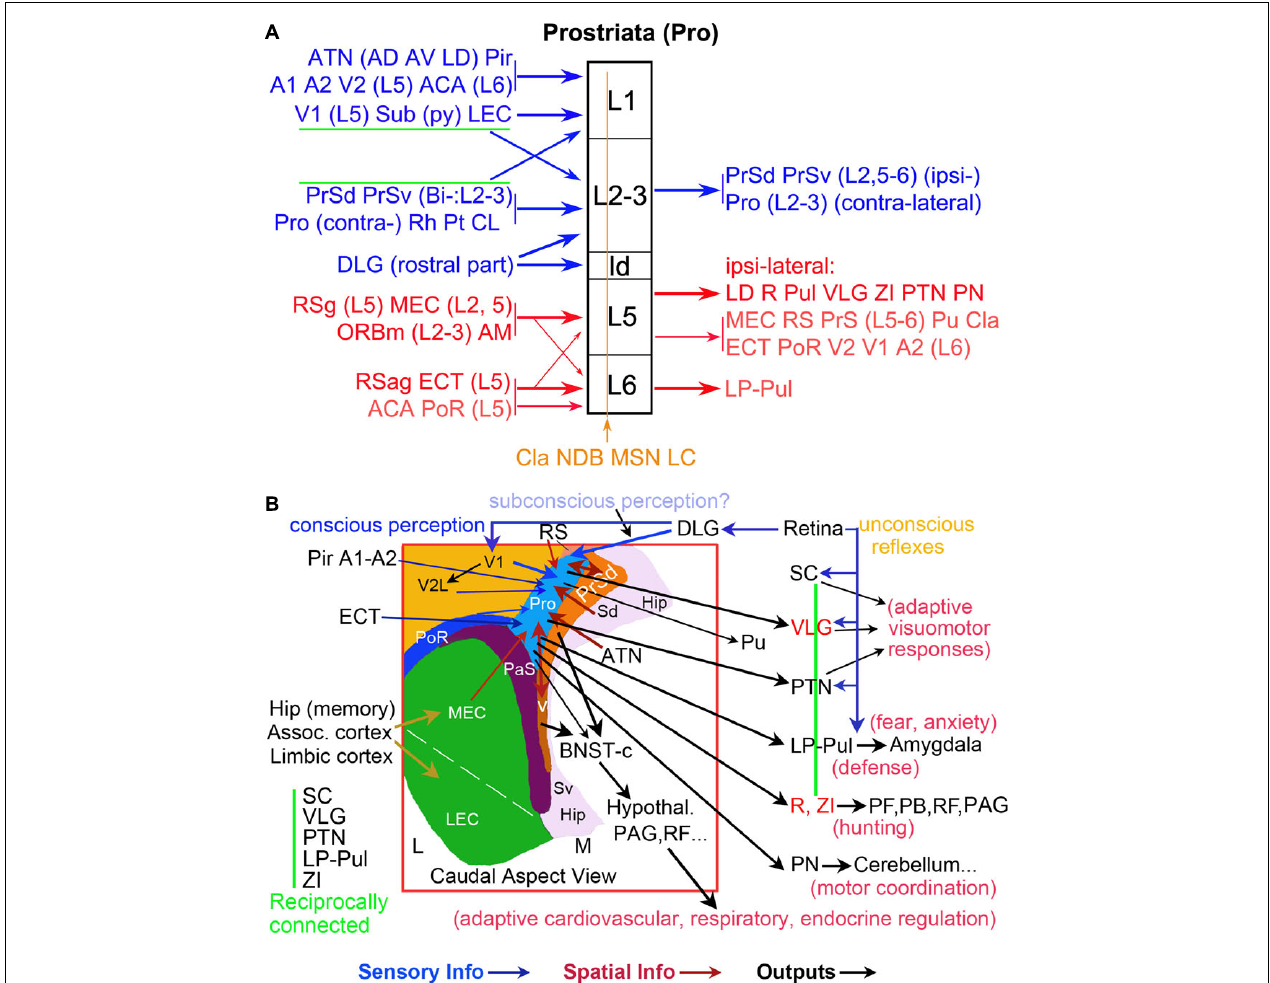
FIGURE 13 | Summary of afferent and efferent projections and wider networks of the prostriata in rodent. (A) Laminar organization of prostriata connectivity. The layers of prostriata (in black) are shown in the middle column. Main afferent and efferent projections are displayed at left and right columns, respectively. Connectivity of the superficial and deep layers of prostriata are, respectively, coded blue and red. Diffuse afferents to all layers of prostriata are coded brown. Thicker and thinner arrows indicate stronger and weaker projections, respectively. Note that layers 2–3 of the prostriata mainly project to PrS and contralateral counterpart (see Chen et al., 2020) and the subcortical outputs of the prostriata mainly originate from layer 5. (B) Topography and wider anatomical networks of prostriata with correlated functions. A schematic map of the region containing prostriata and adjoining areas is shown in the boxed region, which is a caudal aspect view of the left hemisphere. Major sensory inputs (blue arrows), spatial information inputs (red-brown arrows), and outputs (black arrows) are indicated. The vertical green line indicates the five reciprocally connected structures as common effectors of many visuomotor behaviors. The VLG, R, and ZI are coded in red for the feature of mostly GABAergic inhibitory neurons. In general, the direct retinal projections to SC, VLG, PTN, and LP-Pul could be the pathways underlying unconscious reflexes, while the retina–DLG–V1–V2 pathways could be required for conscious perception. The retina–DLG–prostriata pathways likely contribute to subconscious perception and